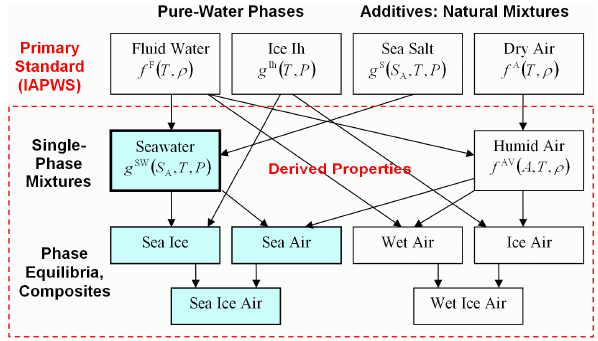
Fig. 1.1: Modular structure of the SIA library illustrated by a selected subset of library routines. Library levels are indicated to the left of the diagram and boxes represent library modules, each of which contains routines that are conceptually related to each other. The Primary Standard consists of implementations of IAPWS formulations for fluid water, ice, sea salt and dry air. All other thermodynamic properties are then derived from this standard using rigorous thermodynamic relations. The numerical solutions of these relations are systematically implemented in a modular framework that consistently determines all quantities from the Primary Standard without the need for separate correlation equations for individual properties. The current implementation of the library is quite extensive (see Table S1 of the supplement) and may be easily extended to provide any desired degree of completeness.